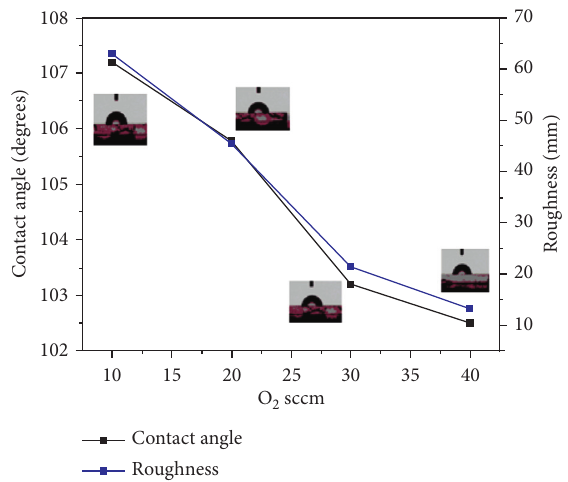
Figure 4: Deviation of contact angle and coarseness at various ratios of